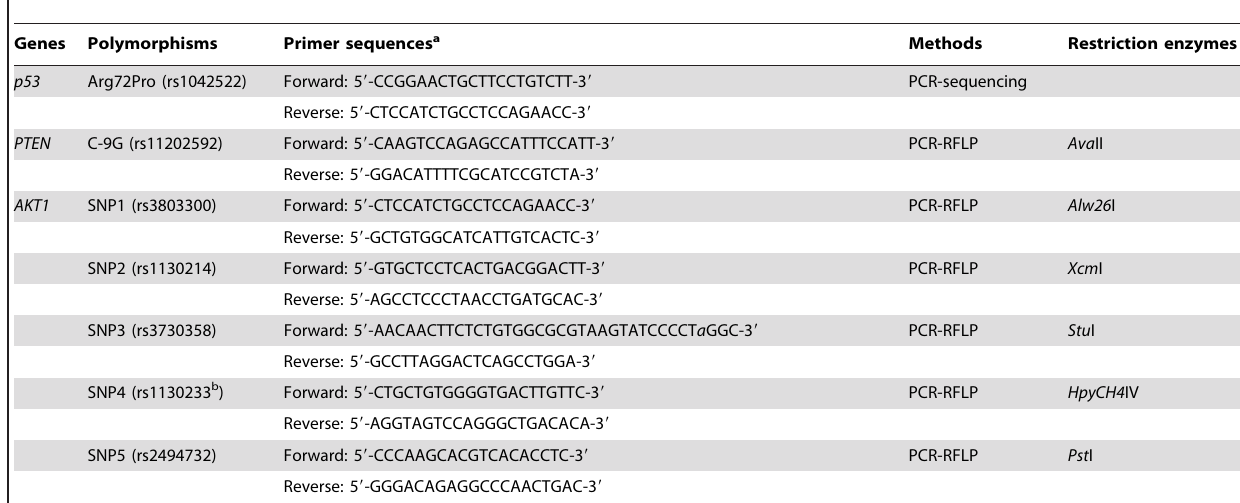
Table 1. Primers and restriction enzymes used to investigate polymorphisms in the PTEN , AKT1 and p53 genes.